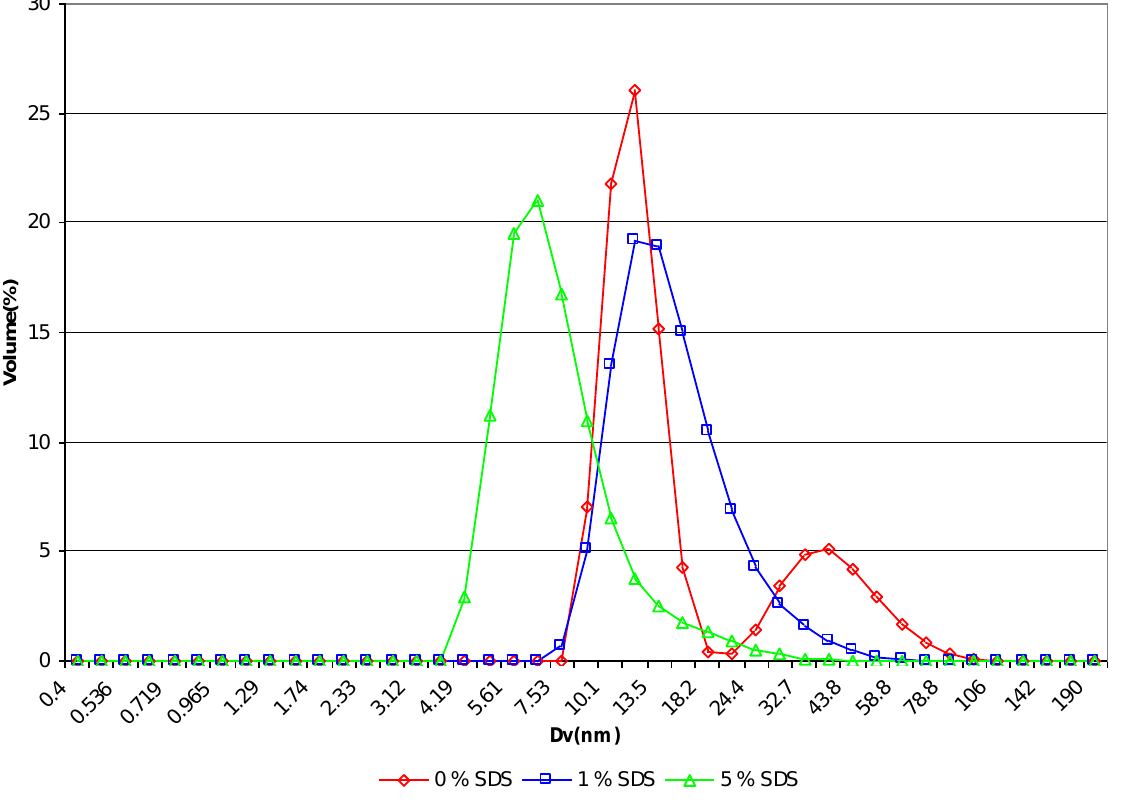
of sample PVA-73-685 (1 wt% 1